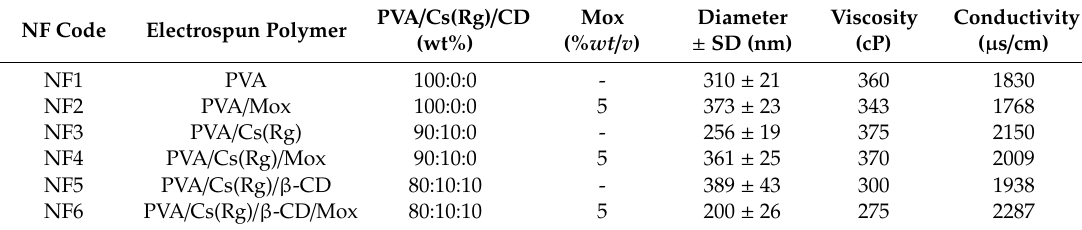
Table 1. Polyvinyl alcohol (PVA) based nanofibrous formulations listed in the present protocol. NF